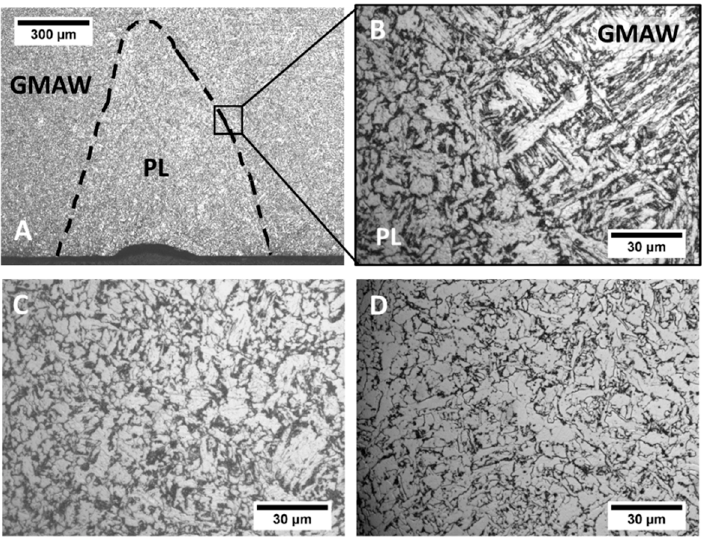
Figure 5. Microstructures of the root layer of the PL + GMAW condition showing in ( A ) the PL region, in ( B ) the processes interface, and in ( C ) the centre of the PL region. In ( D ), the centre of the root layer of the GMAW condition is